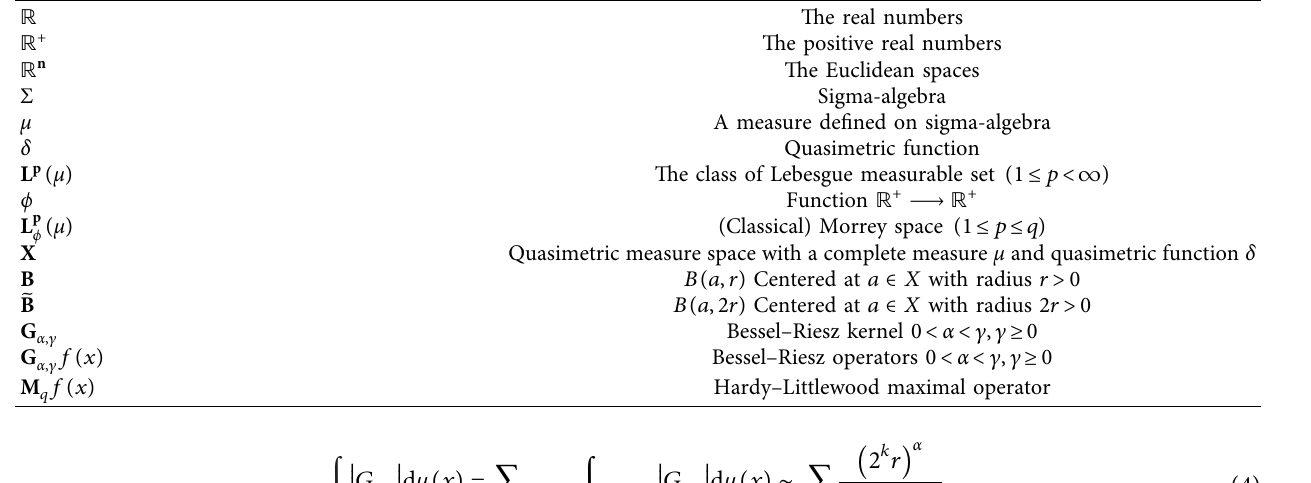
Table 1: Te list of notations used in this